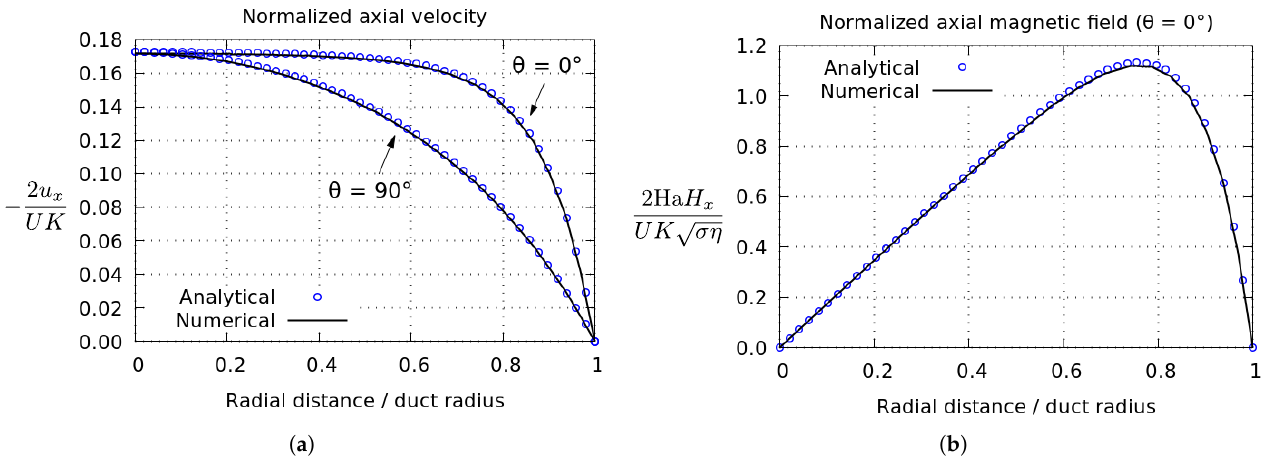
Figure 4. A comparison between numerical and analytical results of ( a ) flow velocity and ( b ) induced magnetic field, both in the axial direction.